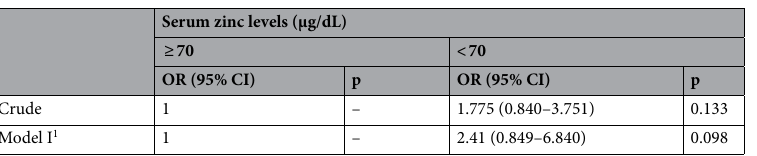
Table 5. Logistic regression for assessing the relationship between zinc deficiency and odds of IBS-D. 1 Adjusted for employment, educational level, zinc intake, depression, anxiety, stress, overall QoL and general health, physical health and psychological